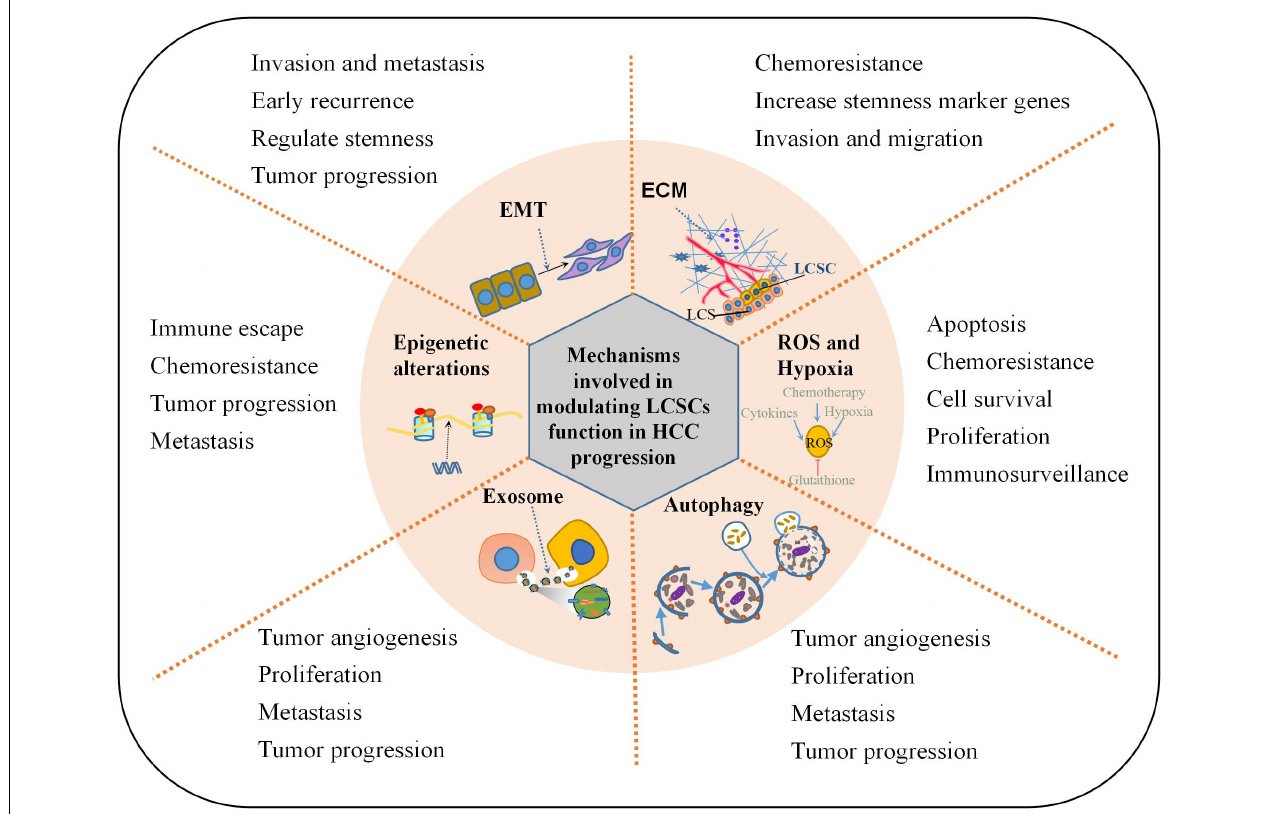
FIGURE 1 | Mechanisms involved in modulating LCSCs function in HCC progression. This illustration encompasses the key mechanisms involved in regulating LCSCs properties in HCC progression: ECM alteration, EMT program induction, oxidative stress resistance, epigenetic control, autophagy modulation, secretion of extracellular vesicles or